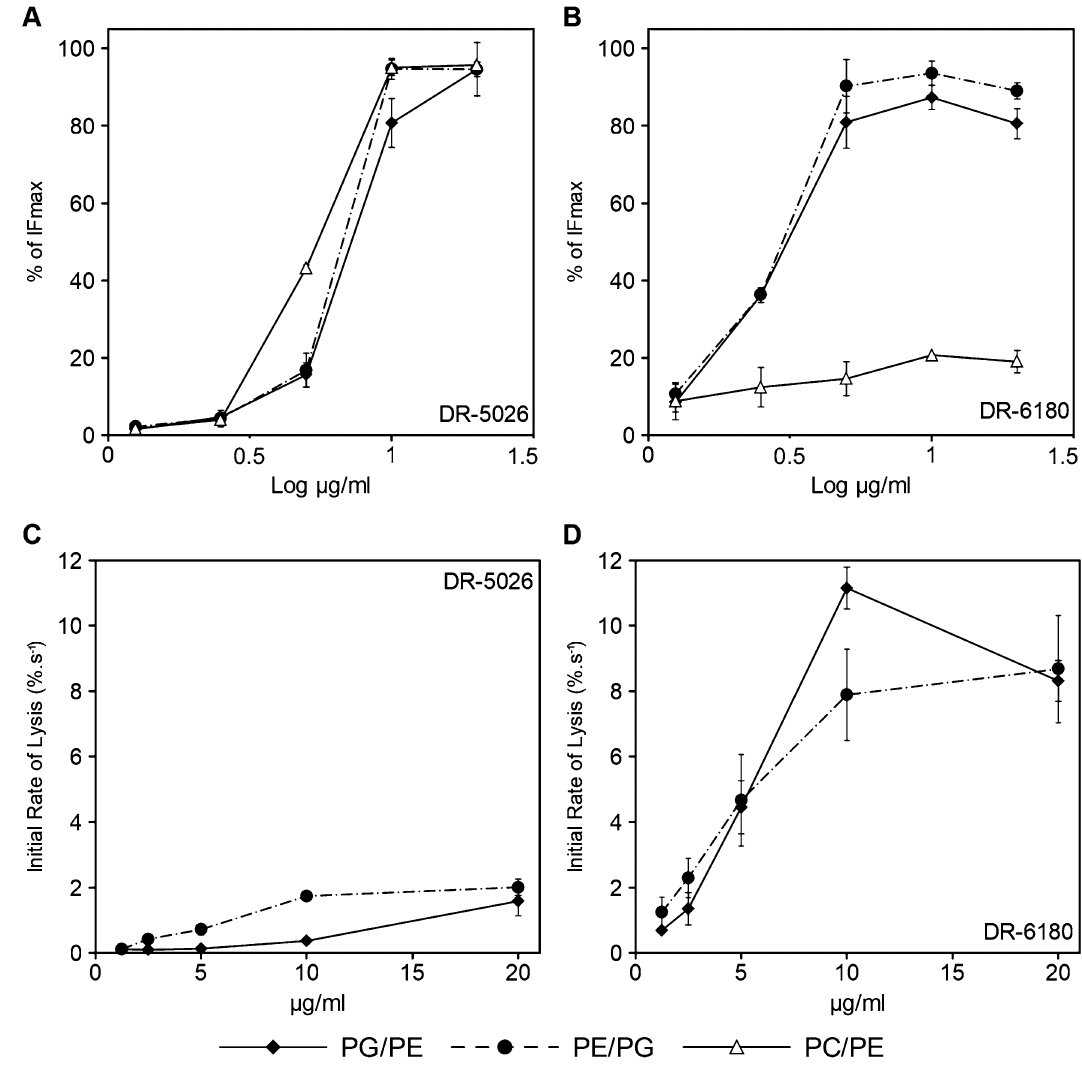
Figure 8. Concentration dependence of maximum LPPO-induced lysis and initial rate of lysis as a function of liposome membrane composition. ( A , B ) The data were taken from Fig. 7 and are plotted as the maximum reached in the plateau after exposure to a given LPPO concentration. ( C , D ) Dependence of the initial rate of lysis on LPPO concentration in liposomes differing in their lipid compositions. Average values from at least three liposome preparations and a standard deviation are